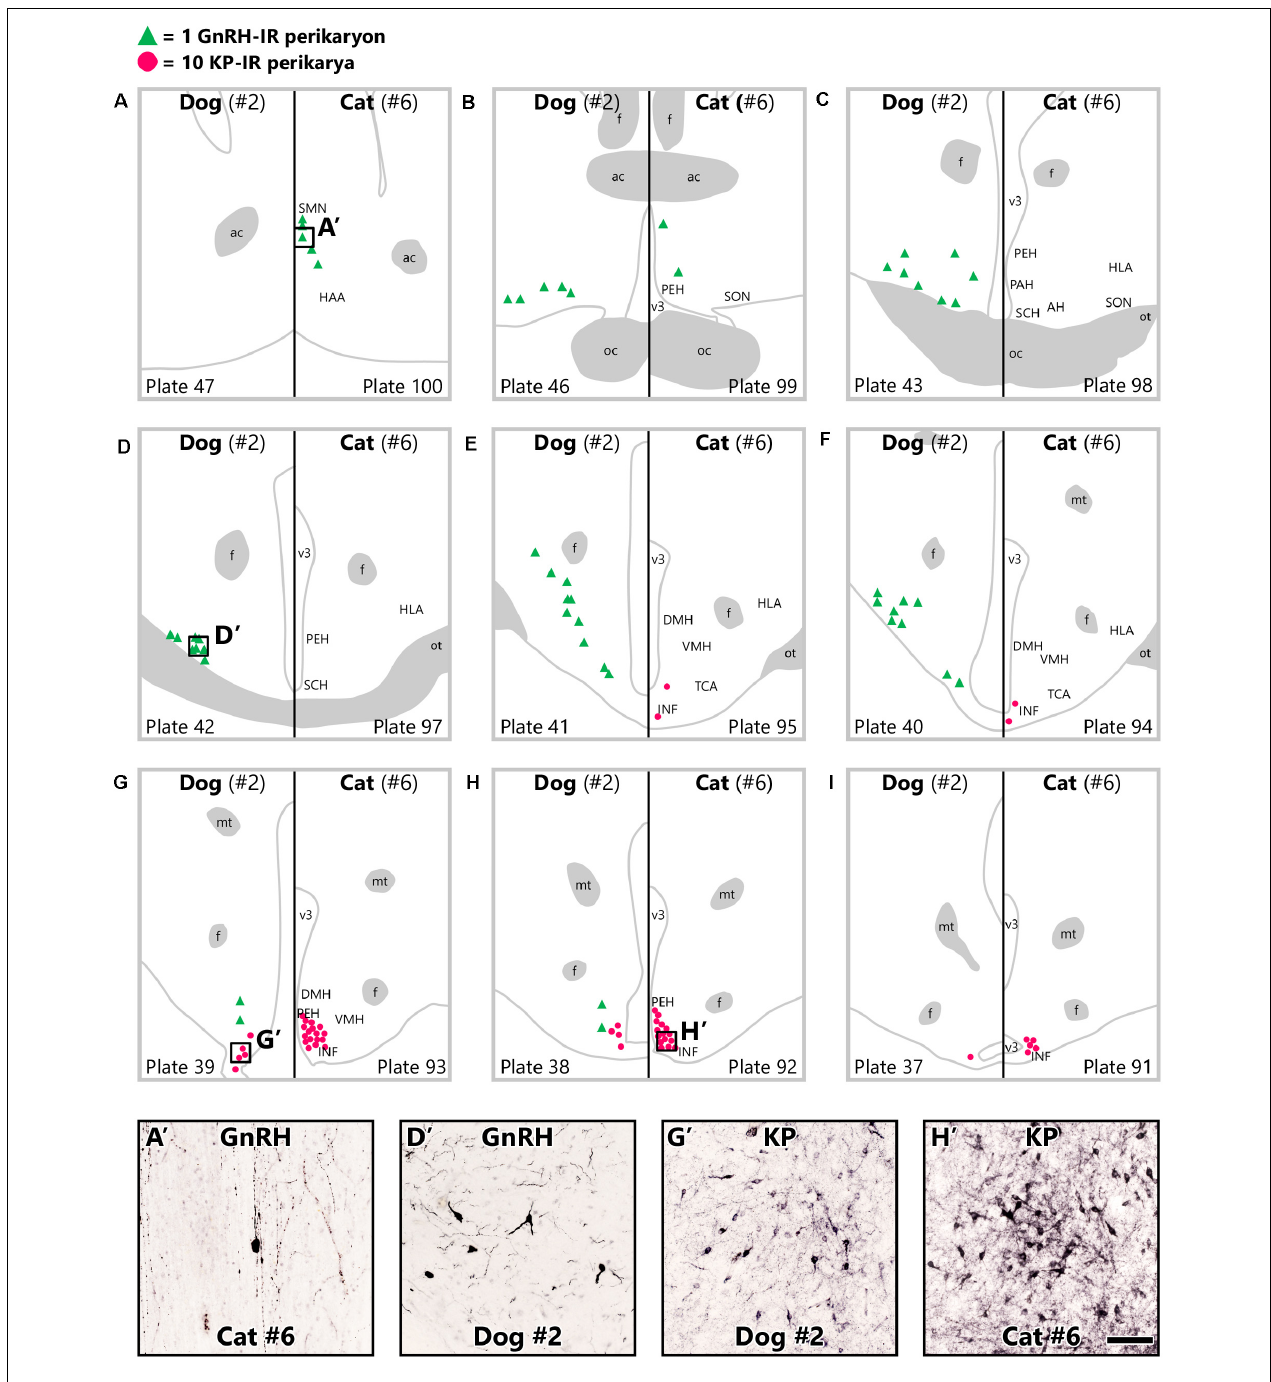
FIGURE 1 | Topography of gonadotropin-releasing hormone and kisspeptin neurons in ovariectomized dogs and cats. Gonadotropin-releasing hormone (GnRH) neurons (green triangles) are scattered throughout the hypothalamus in ovariectomized (OVX) dogs and restricted to the septal-preoptic region in OVX cats. While kisspeptin-immunoreactive (KP-IR) neurons (red dots) are concentrated in the caudal infundibular nucleus in OVX cats as well as dogs, they also occur somewhat more rostrally in the feline mediobasal hypothalamus. Serial coronal schemas were (A–I) obtained from BrainMaps: An Interactive Multiresolution Brain Atlas (BrainMaps.org) (Mikula et al., 2007). Each green triangle corresponds to a single GnRH neuron and each red dot represents 10 KP-IR somata from animals D#2 and C#6. Representative photomicrographs at the bottom display immunolabeled GnRH and KP neurons from OVX cats (A’,H’) and dogs (D’,G’) , respectively. ac, anterior commissure; AH, anterior hypothalamic nucleus; DMH, dorsomedial hypothalamic nucleus; f, fornix; HAA, anterior hypothalamic area; HLA, lateral hypothalamic area; INF, infundibular nucleus; mt, mammillothalamic tract; oc, optic chiasm; ot, optic tract; PAH, paraventricular nucleus of the hypothalamus; PEH, periventricular complex of the hypothalamus; SCH, suprachiasmatic nucleus; SMN, medial septal nucleus; SON, supraoptic nucleus; TCA, area of the tuber cinereum; v3, third cerebral ventricle; VMH, ventromedial hypothalamic nucleus. Scale bar: 100 µ m.